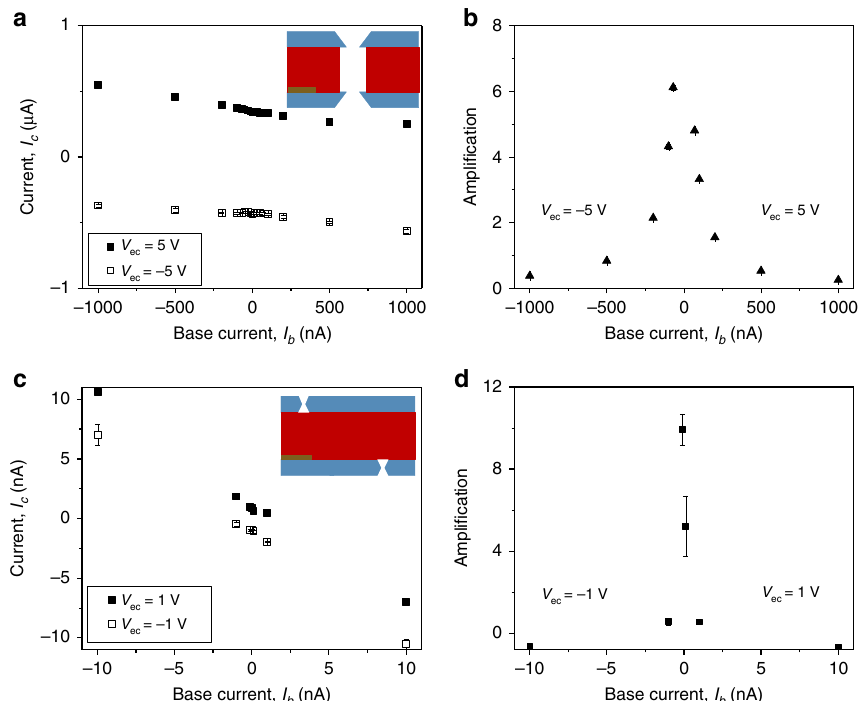
Fig. 4 Ampli fi cation performance of ionic bipolar junctions. a , b Measurements for an ionic transistor with an opening diameter of 540 nm in 1 mM KCl. a Current, I c , at a collector voltage of either V ec = − 5 V or V ec = 5 V as a function of base current, I b . b Current gain calculated as a function of base current. Values calculated for V ec = − 5 V at negative base currents, and V ec = 5 V at positive base currents correspond to the active mode of the device. c , d Measurements for an ionic transistor with an opening of 140 nm in 100 mM KCl. c Current, I c , at a collector voltages of − 1 V and + 1 V as a function of base current together with current gain shown in d calculated at V ec = ±1 V. Error bars were calculated as standard deviation from an average of values in at least two voltage